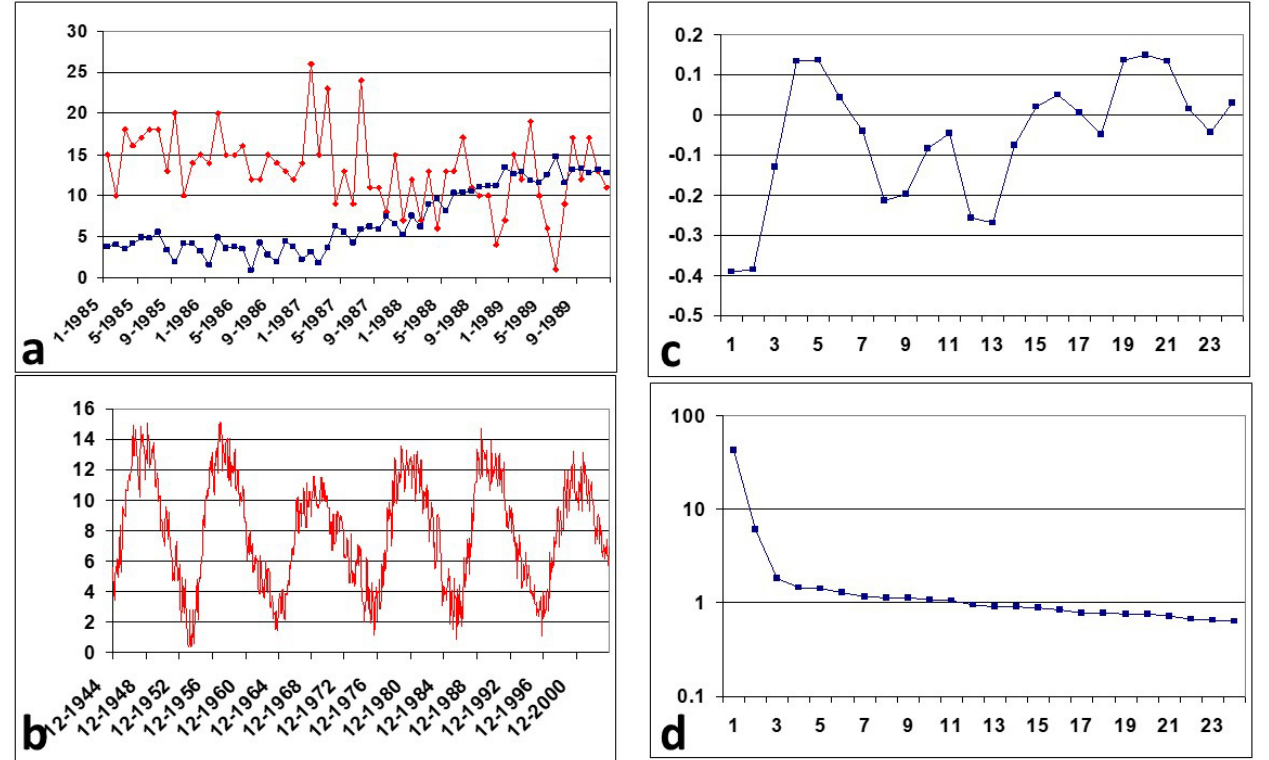
Figure 1. Singular spectrum analysis results. ( a ) Time series of stroke deaths and sunspots from January 1985 to December 1989. A square root transformation is applied to the time series of the sunspots. ( b ) Time series of sunspots from December 1984 to November 2004. ( c ) Pearson correlation coefficient between the principal components of the sunspots and strokes time series. ( d ) Singular values of the transformed sunspots time series. The noise plateau clearly begins at the third-ordered singular